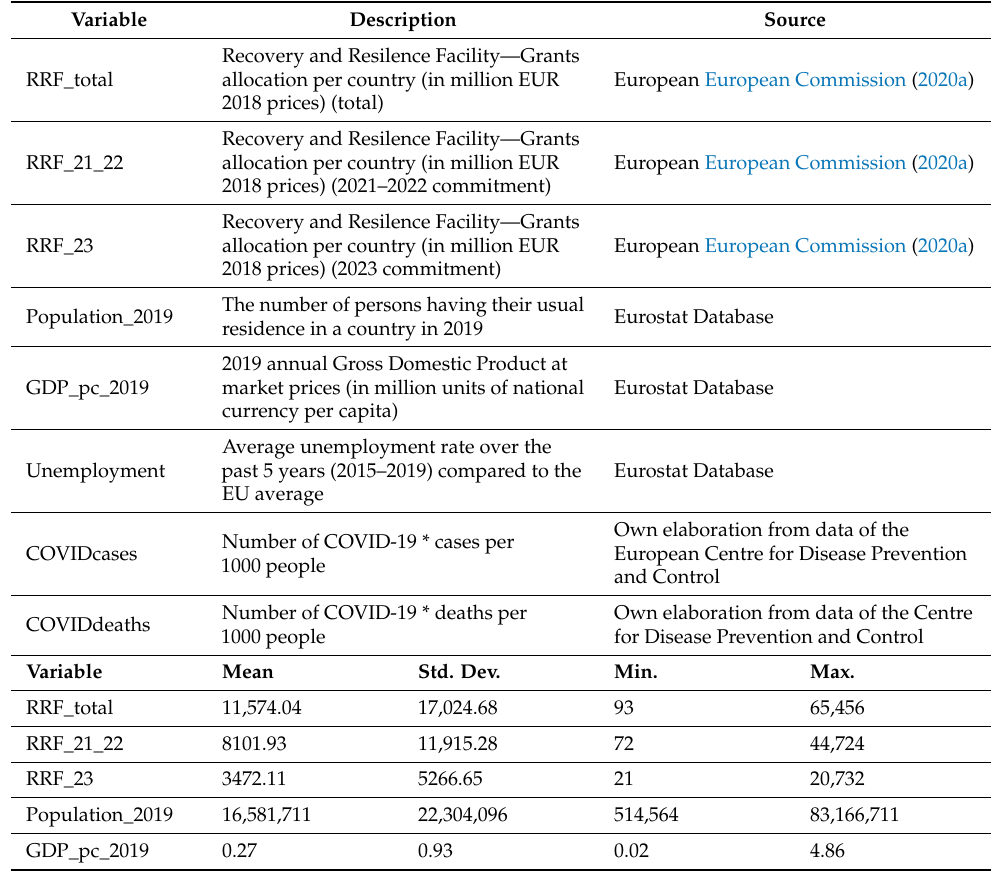
Table 1. Definition of variables and descriptive